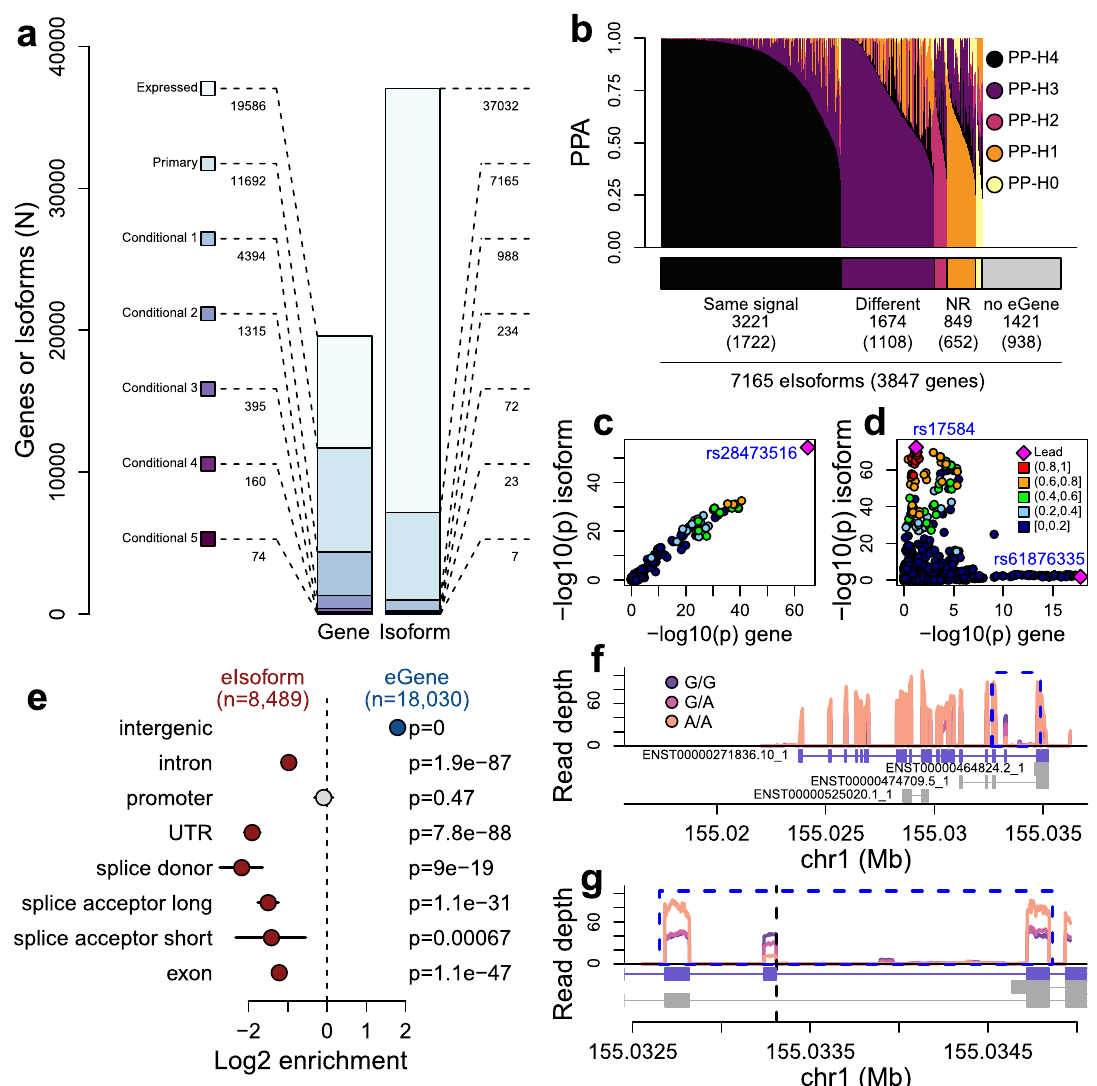
Fig. 1 | Gene and isoform eQTLs. a Barplot showing the number of eQTLs for eGenes (left) and eIsoforms (right). Colors represent the number of eGenes with primary and conditional eQTLs (up to fi ve conditional signals). b Barplot showing the distribution of PPA for each of the fi ve colocalization hypotheses. All the colocalizations associated with hypothesis 0, 1, and 2 were likely underpowered, thustheywerelabeledas “ notresolved(NR) ” .The1421eIsoformswhoseassociated gene did not have an eQTL were labeled as “ no eGene ” . c , d Examples of ( c ) eQTL signalforaneGene ( B4GALT7 ) thatcolocalizes with PPA=1 with the eQTLsignalof one associated eIsoform and ( d ) eQTL signal for an eGene ( RNH1 ) that does not colocalize with the eQTL signal of one associated eIsoform. In each plot, X axis represents the − log 10 (eQTL p-value) for the associations between the genotype of eachtestedvariantandgeneexpression,whereastheYaxisshowsthe − log 10 (eQTL p-value) for the associations between the genotype of each tested variant and isoform use. e Enrichment of eGenes compared with eIsoforms for overlapping